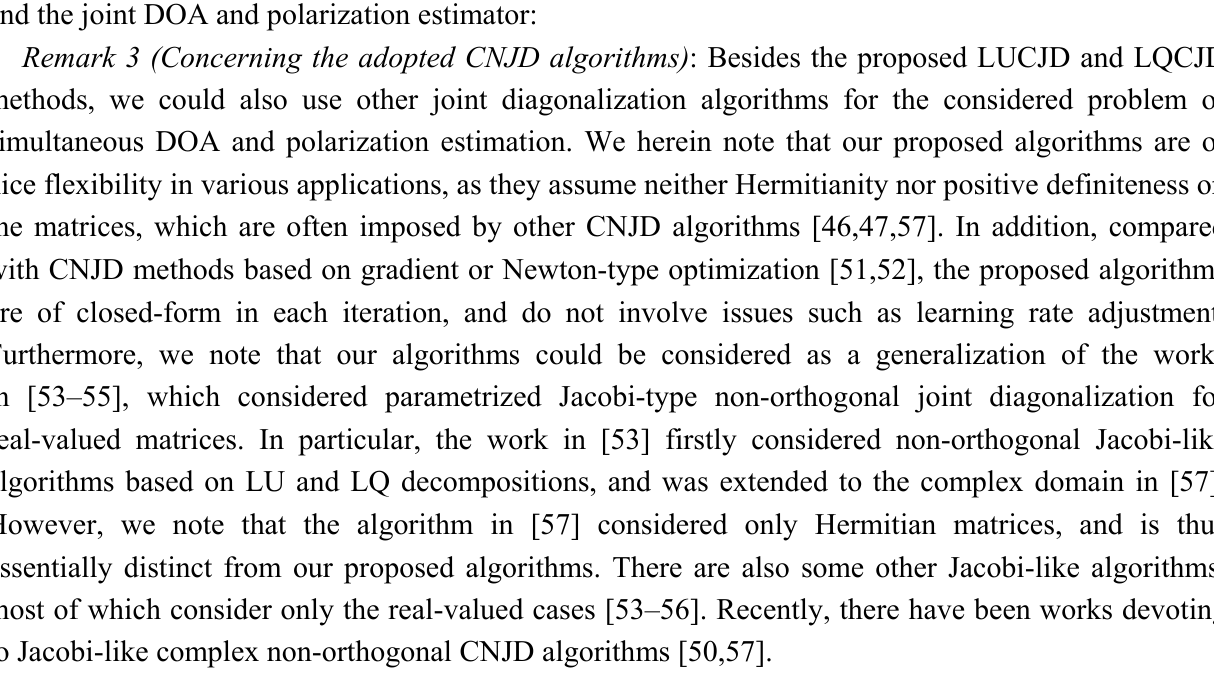
Table 2. The proposed joint DOA and polarization estimation